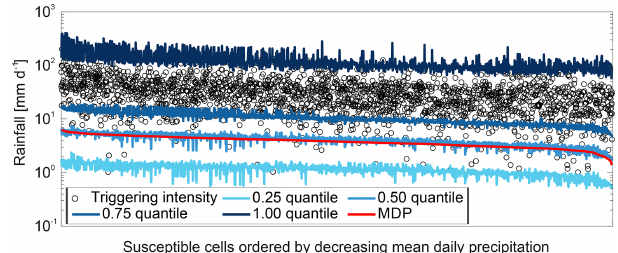
Figure 6. Wet quantiles of daily intensities, mean daily precipitation (MDP = mean annual precipitation/365) and maximum daily trig- gering intensities for all the susceptible cells (rainfall cells with at least one landslide). The cells are sorted ( x axis) by value of MDP, left to right from the cell with the highest to lowest MDP. Markers show the daily rainfall intensities of triggering events for each